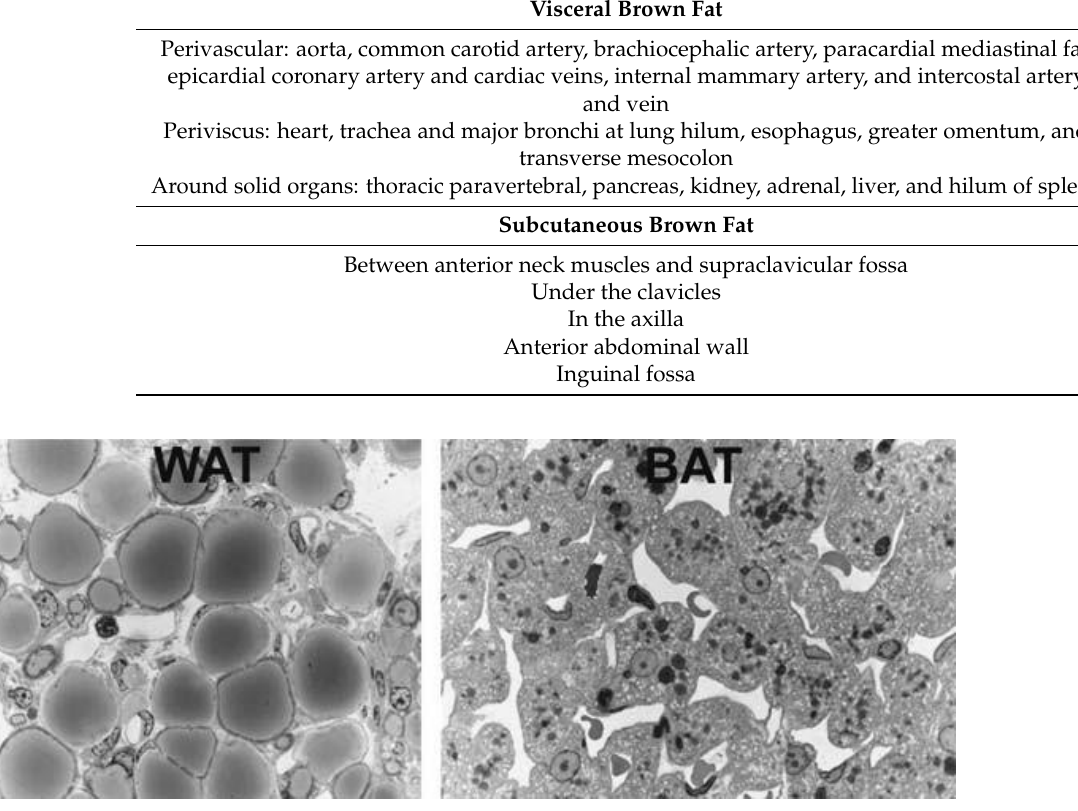
Figure 2. Light microscopy of murine white adipose tissue (WAT), left, and brown adipose tissue (BAT), right. White adipocytes are roundish with unilocular lipid droplets. Brown adipocytes are polyhedral with multilocular lipid droplets and a centrally positioned nucleus. From: [10] (reproduced with permission).